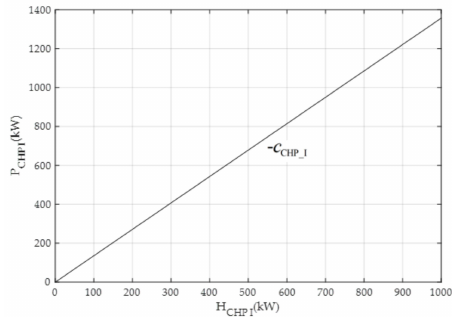
Figure 2. Relationship between thermal and electricity power generation of combined heat and power (CHP) units with fixed heat-to-electricity